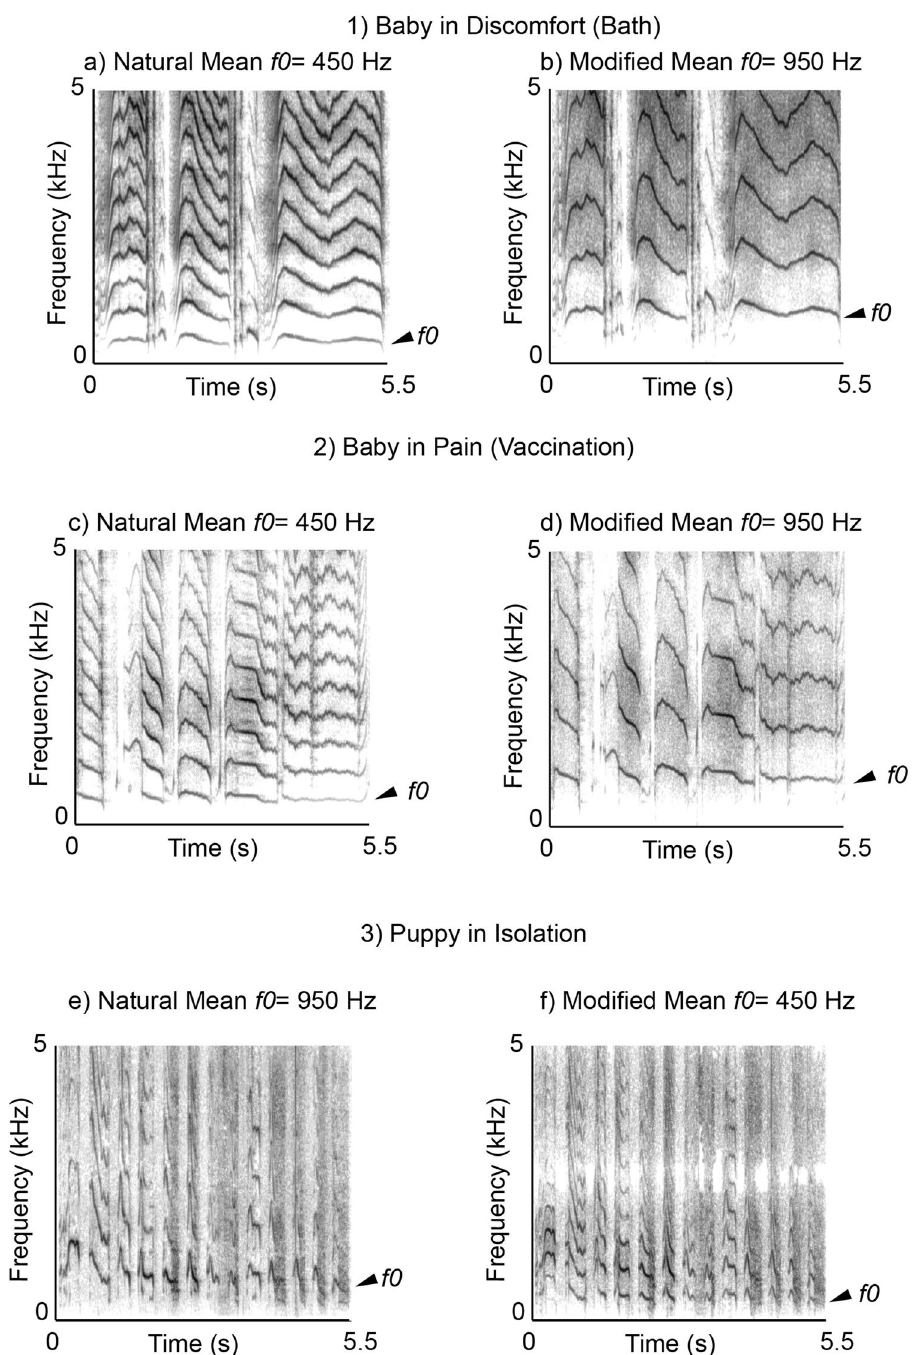
Figure 3. Spectrograms exemplifying the different cry types used. Each cry was resynthesised and presented at both the typical human-baby frequency range of mean = 450 Hz, which the dogs should consider heterospecific, and at the typical puppy frequency range of mean = 950 Hz, which the dogs should consider conspecific: ( a ) the distress cry from a human baby in a bathtub at natural, 450 Hz mean pitch (discomfort-baby heterospecific 450 Hz), ( b ) the same baby cry modified to 950 Hz mean pitch (discomfort-baby conspecific 950 Hz), ( c ) a second baby’s cry following vaccination at natural, 450 Hz mean pitch (baby-vaccination heterospecific 450 Hz), ( d ) the same cry modified to 950 Hz mean pitch (baby-vaccination conspecific 950 Hz), ( e ) approximately 9-week old puppy crying while isolated, presented at modified, 450 Hz mean pitch (puppy-heterospecific 450 Hz), and ( f ) the same puppy cry presented at natural, 950 Hz mean pitch (puppy-conspecific 950 Hz). The spectrogram settings were: FFT = 1024, viewing range 0–5000 Hz, window length = 0.05 s, time step = 0.005